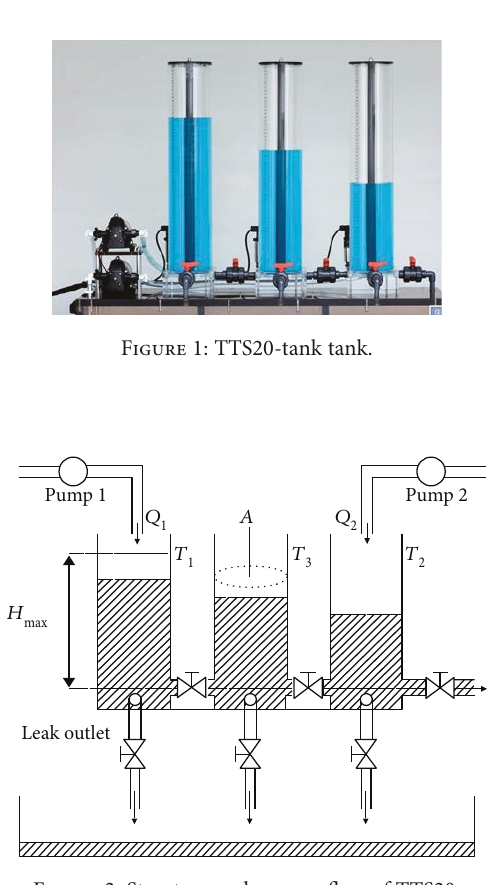
Figure 2: Structure and process fl ow of